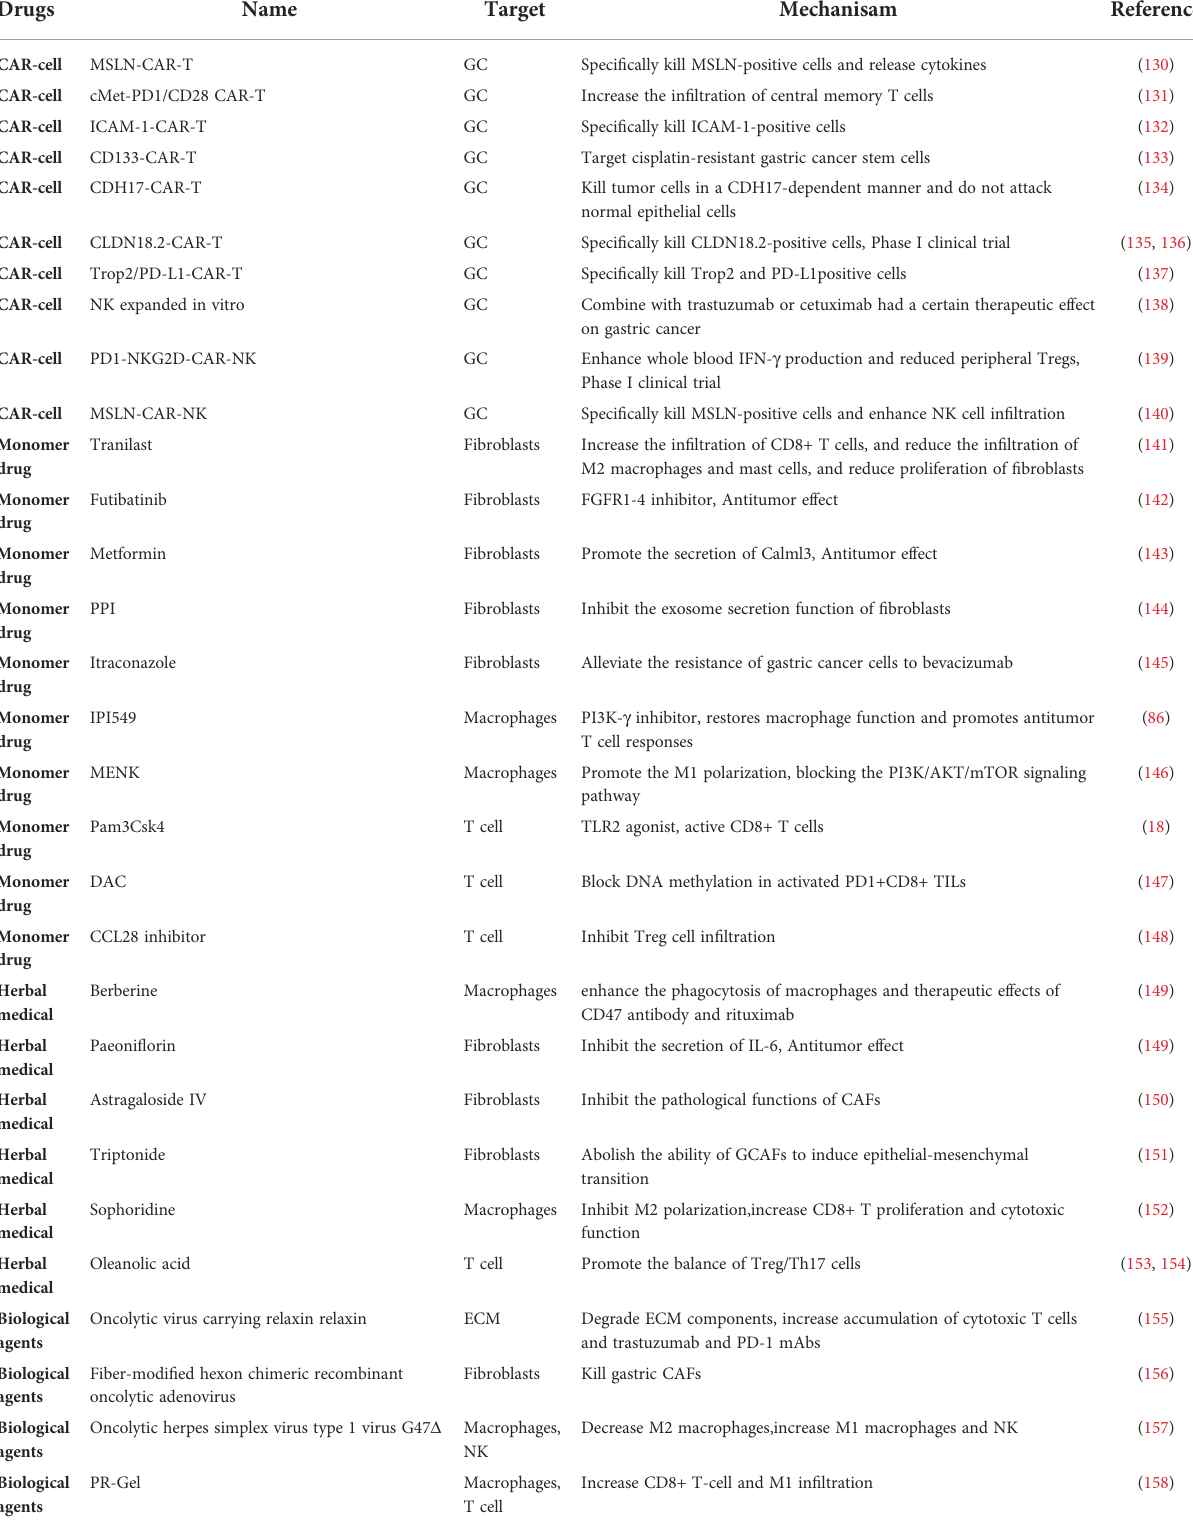
TABLE 1 Therapeutic strategies targeting tumor immune tolerance in GC